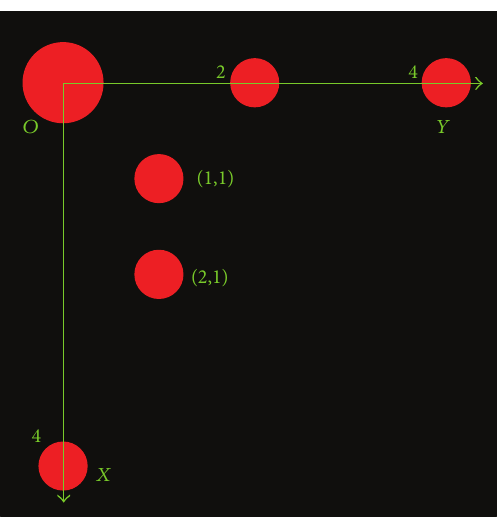
Figure 3: Design of coded